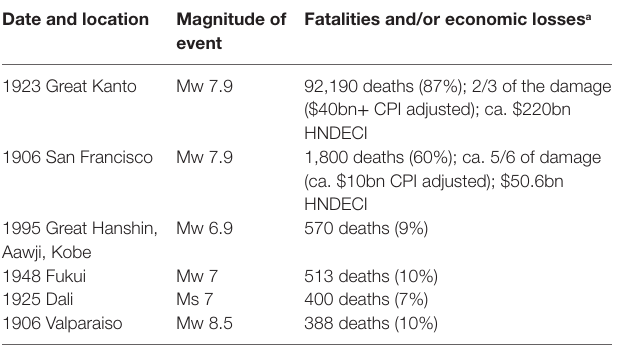
Table 5 | The effect of larger fire events since 1900.